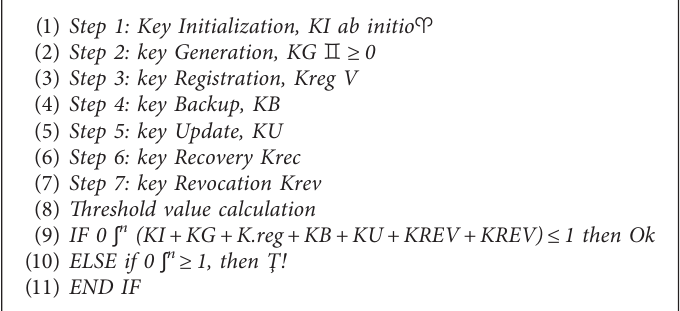
A LGORITHM 1: Algorithmic evaluation ( ♈ , ♊ , ʃ